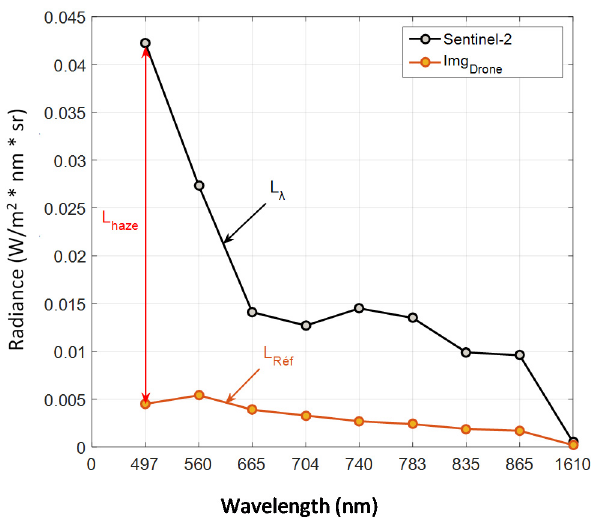
Figure 10. A novel approach for quantifying the L haze using image drone radiance as a reference. The spectral reflectance presented in the red frame of Figure 11 illustrates the result of the COST Mod algorithm based only on the blue band radiance as a reference, while the spectral reflectance presented at the blue frame illustrates the result of the COST Mod algorithm based on all bands radiance as a reference. It is clear that the reflectance along the spectrum (from the blue to NIR) picked up from the image corrected with the COST Mod blue band radiance-based is closer to the known case-1 water spectral behavior. On the other hand, correcting independently the L haze for each Sentinel-2 band leads to destroying of the intrinsic physical relationships along the spectrum within the image. This fact is more tangible in the case of waters since the returned signal is initially too small and any slight over- or under-estimation of the L haze could change the initial spectral behavior, as shown in the blue frame of Figure